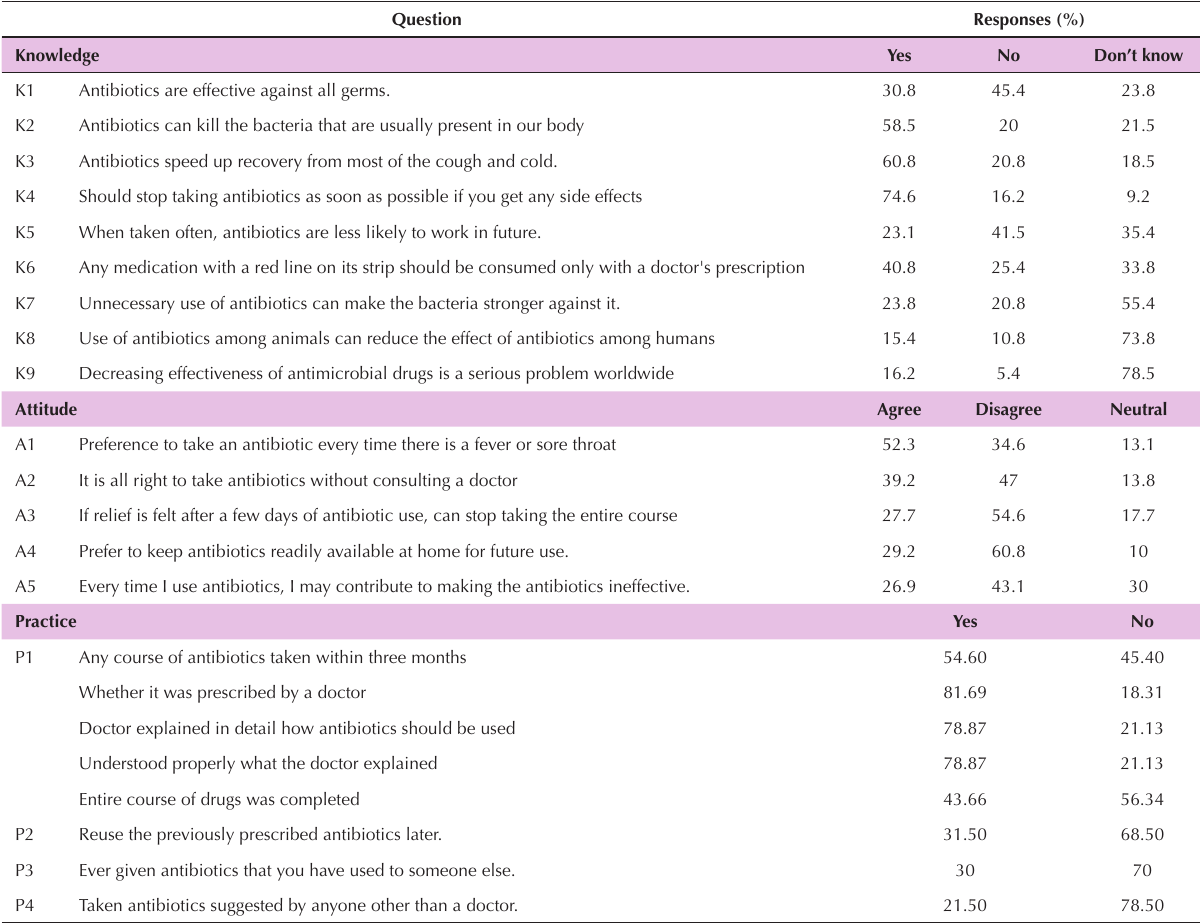
Table 2. Participants’ responses to the knowledge, attitude, and practice questions